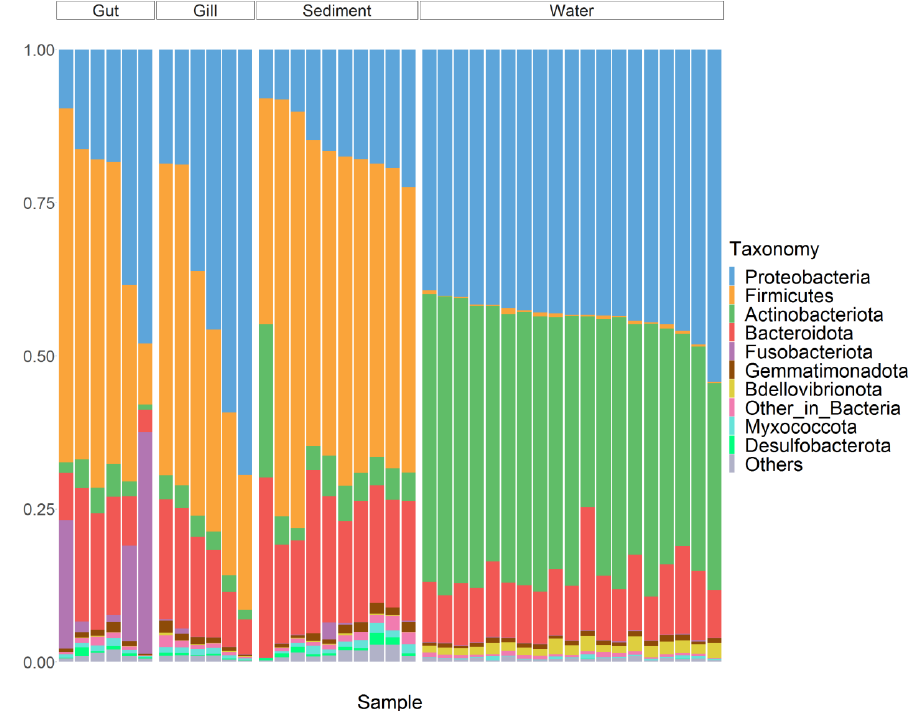
Figure 3. The phylum-level taxonomic composition of microbiotas in the IPRS. Only the top 10 phyla with an average proportion are displayed, and the vertical axis represents the relative proportion of each